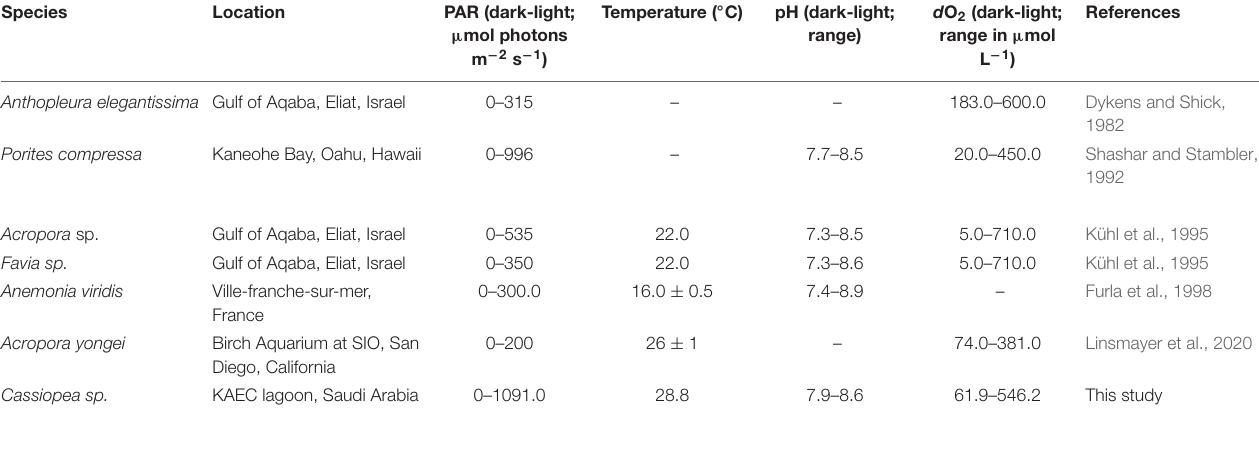
TABLE 2 | Summary of oxygen and pH fluctuations in the body of different cnidarian and a comparison with findings deriving from this study. Species